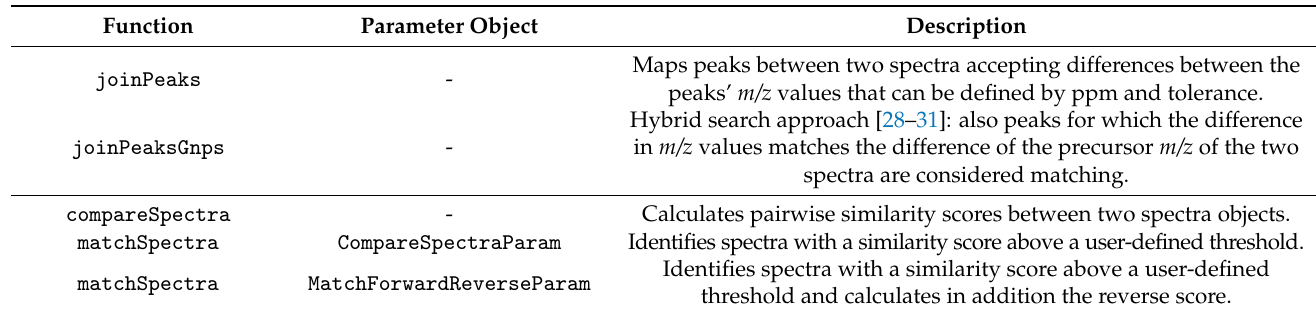
Table 3. Functions for MS 2 -based annotation. The first panel contains function to map peaks between compared spectra. The second panel high-level functions to perform spectra similarity